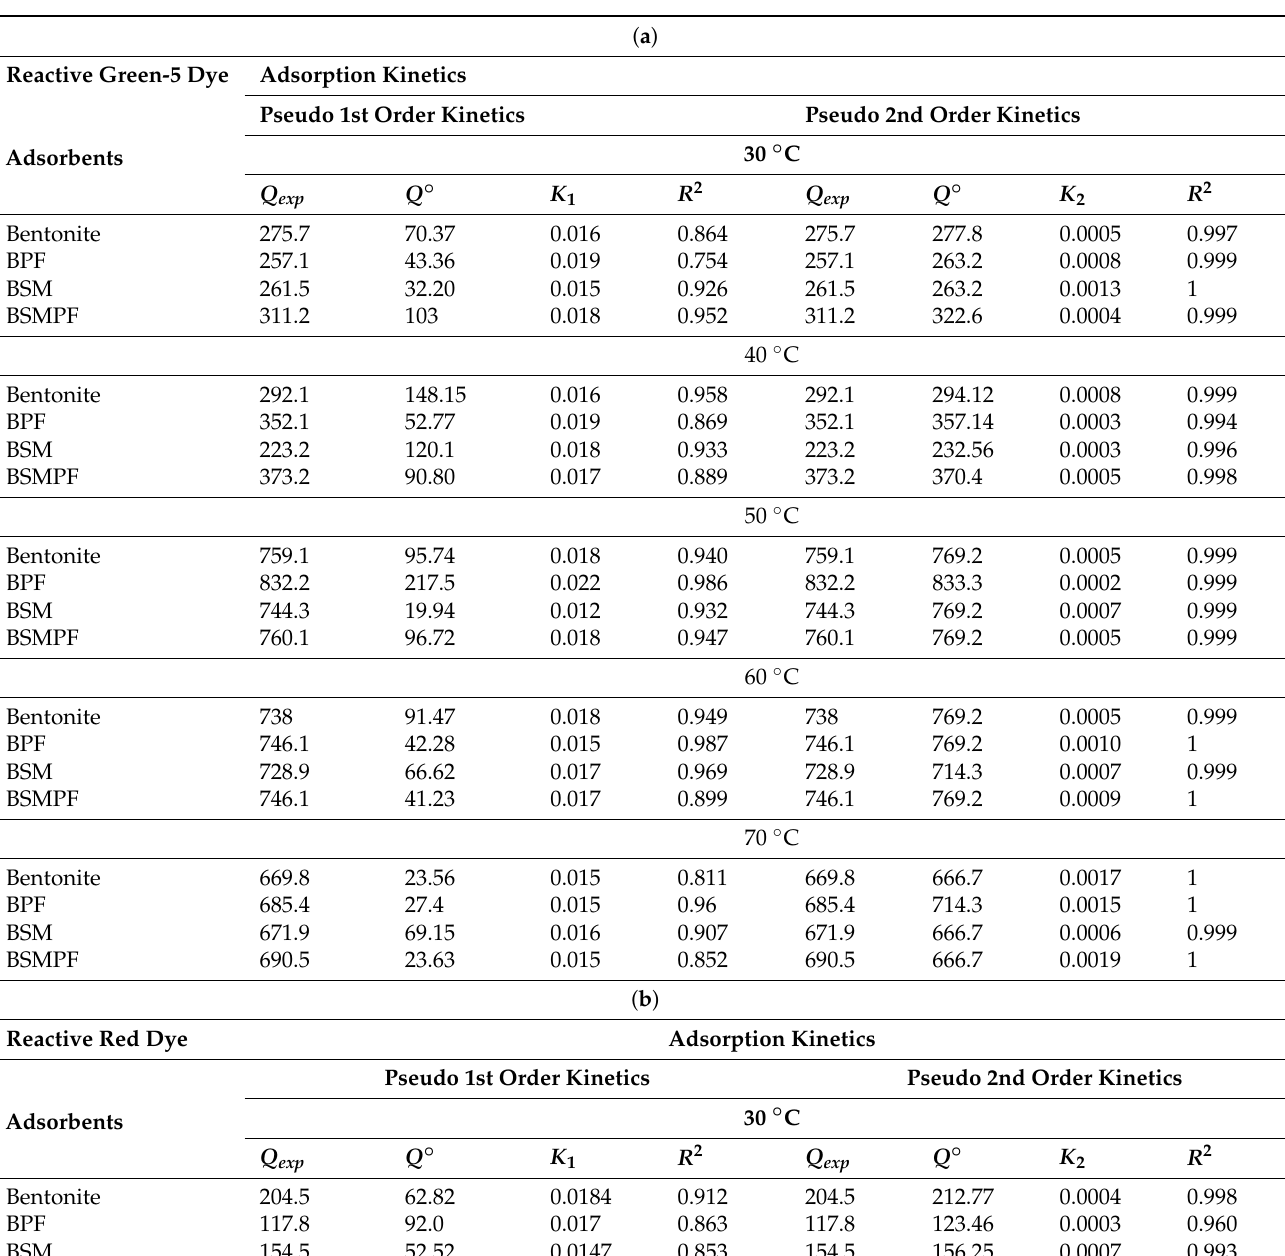
Table 2. ( a ) Adsorption kinetics data for Reactive green-5 dye. ( b ) Adsorption kinetics data for Reactive red dye. ( c ) Adsorption kinetics data for Acid red dye. ( d ) Adsorption kinetics data for Violet-51